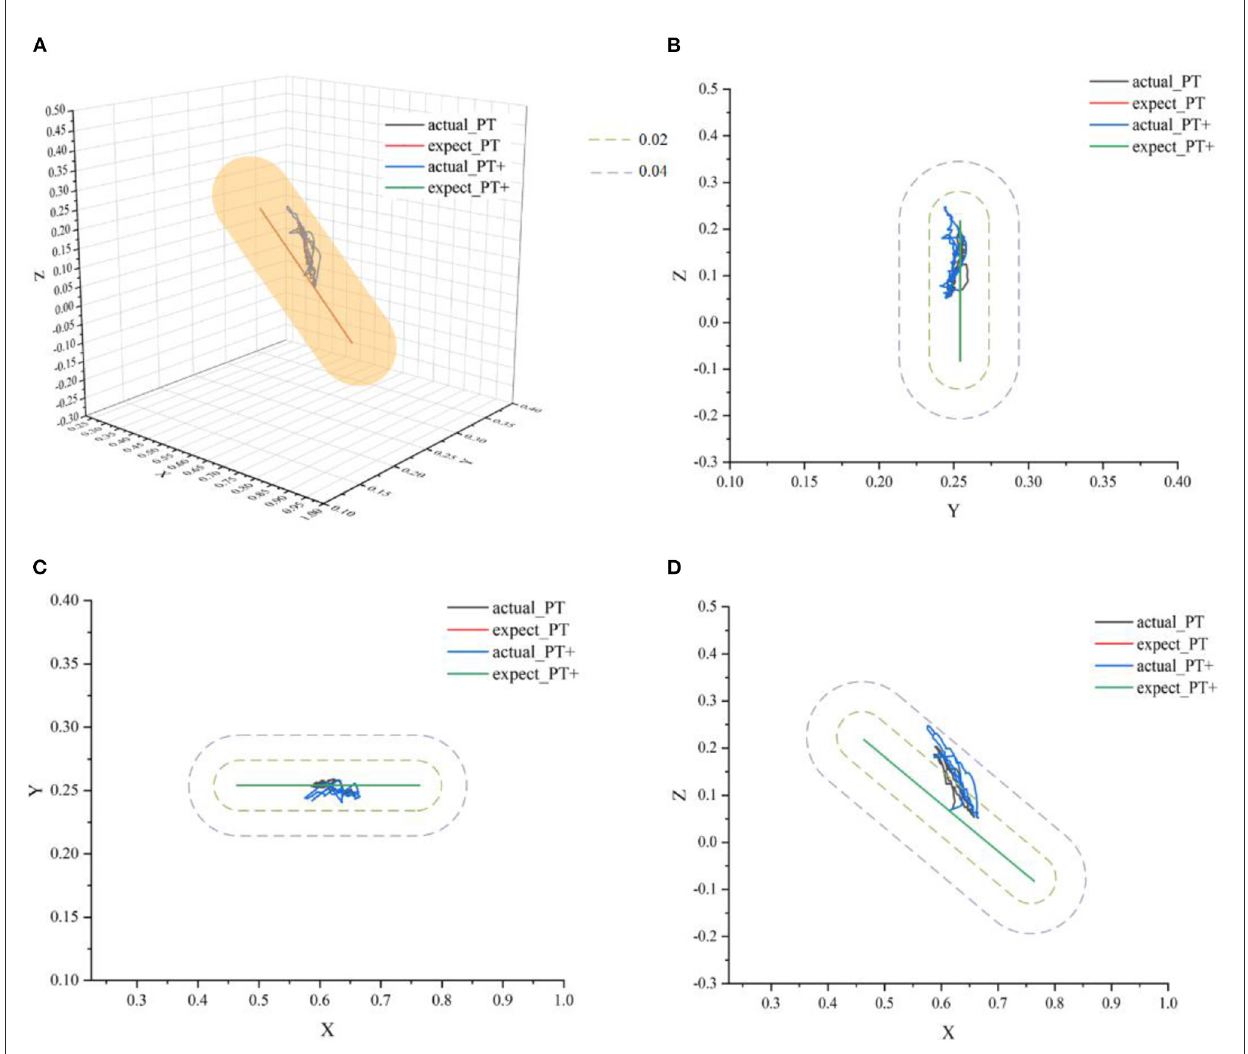
FIGURE10 The ideal movement trajectory and the actual training trajectory in the passive training mode: (A) three-dimensional spatial view; (B) YOZ view; (C) XOY view; (D) XOZ